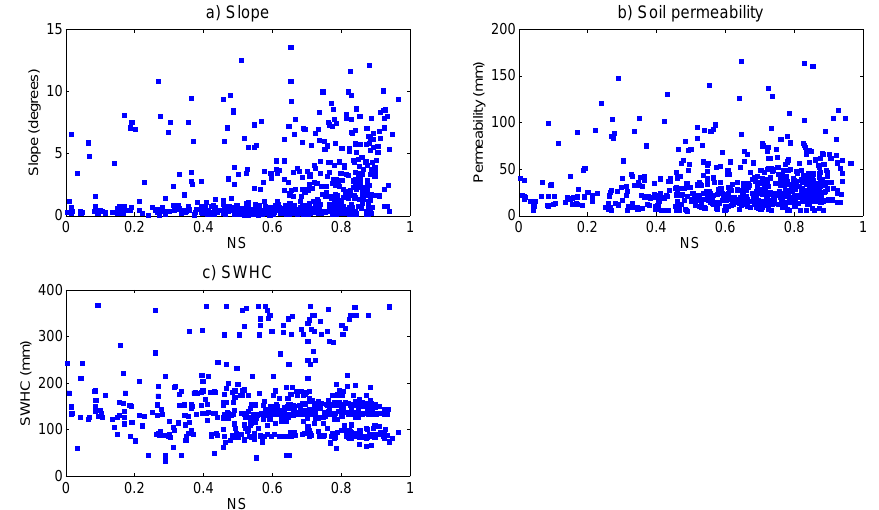
Fig. 7. Relationship between Nash Sutcliffe efficiency (NS) and (a) channel slope, (b) soil permeability, and (c) soil water holding capacity (SWHC).